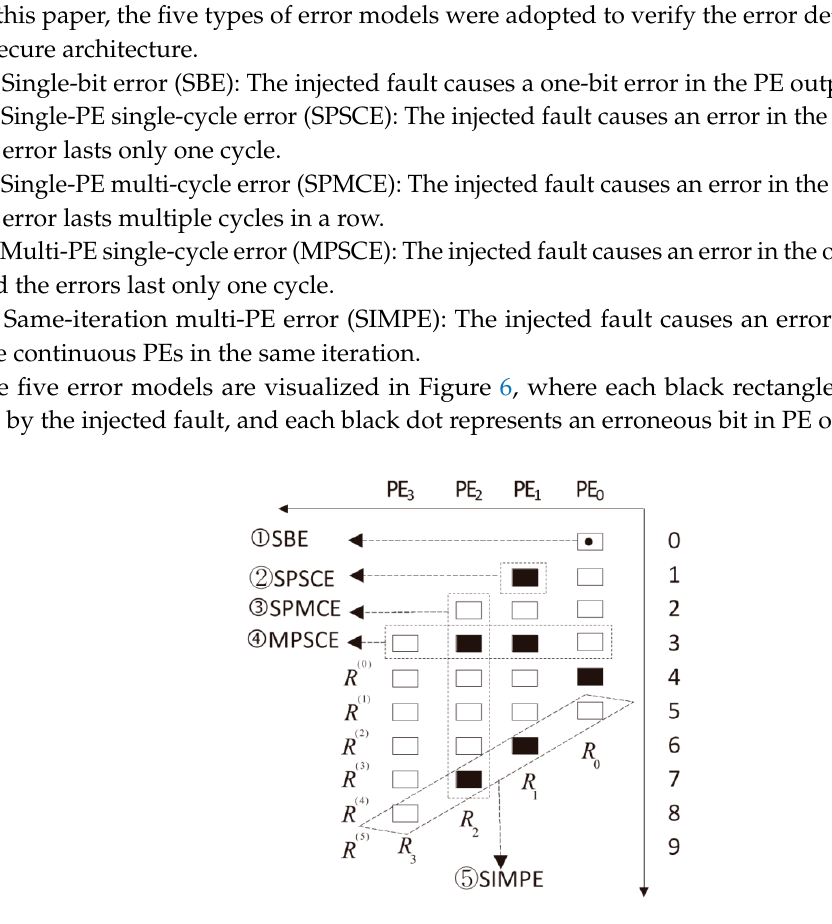
Figure 6. Five types of error models.